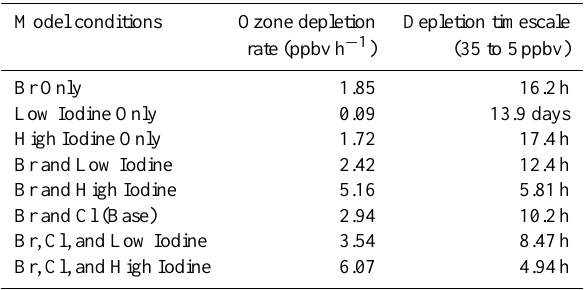
Table 8. Ozone depletion rates in ppbvh − 1 calculated by Eq. (3) and the corresponding timescale for ozone depletion from 35 to 5ppbv for mid-day of 29 March for eight different modeling sce- narios with different combinations of halogen radicals present. “Br and Cl” is the Base